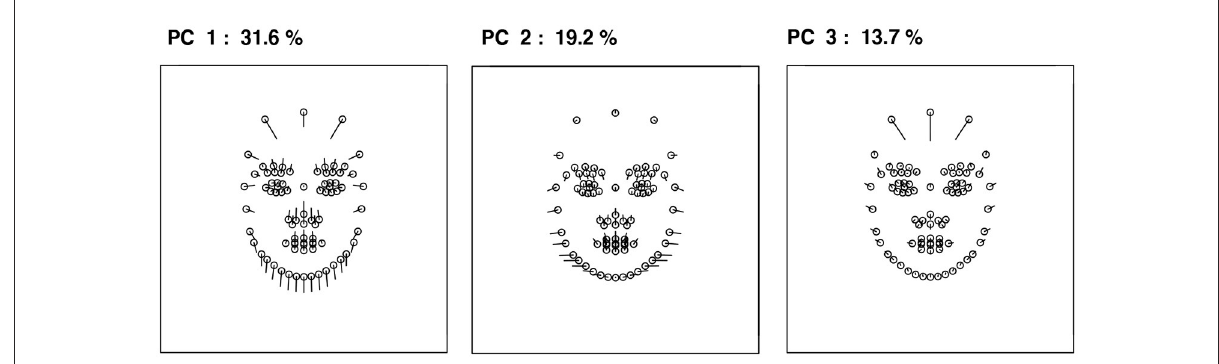
FIGURE2 Facial shape changes along each PC. When the score of each PC increases, each facial landmark (depicted as a circle) moves along the leading line.